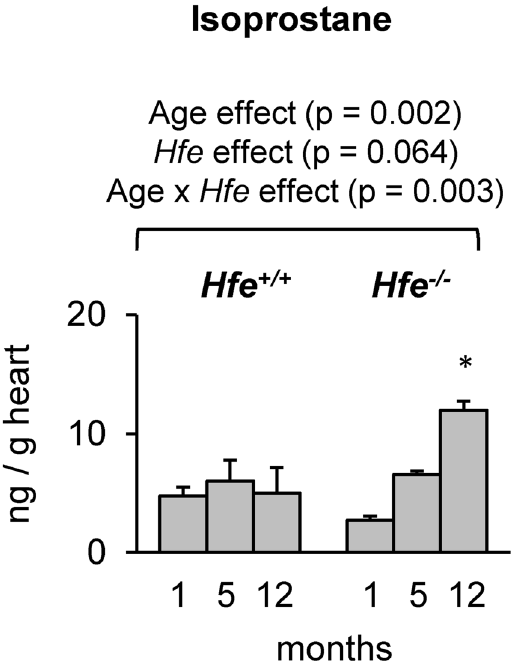
Figure 5. Levels of isoprostane in Hfe + / + and Hfe − / − mice. Levels of isoprostane in the heart of Hfe + / + and Hfe − / − mice (n = 5 per group) at 1, 5, and 12 months of age were determined by 8-isoprostane kit. Data are presented as the means ± SEM. * p < 0.05 between Hfe − / − and Hfe + / + mice assessed by the two-way ANOVA, followed by the Tukey’s post-hoc